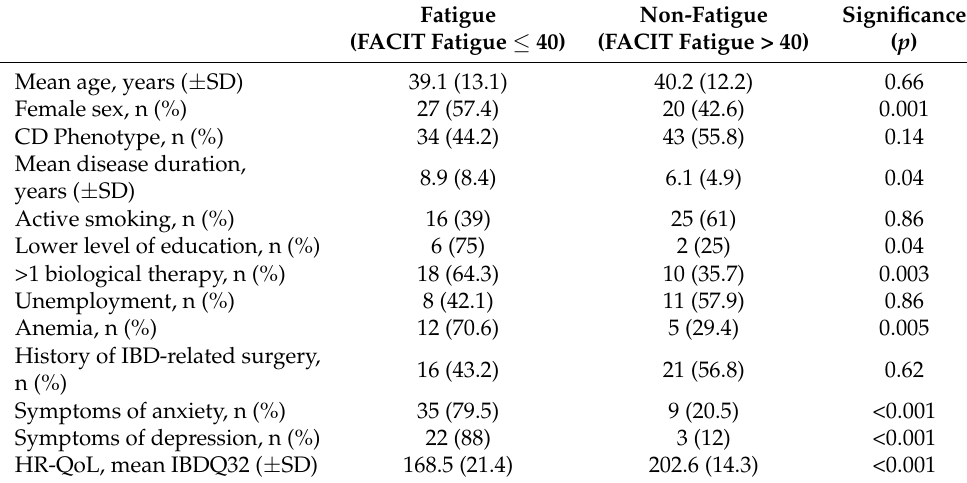
Table 2. Univariate analysis of factors associated with